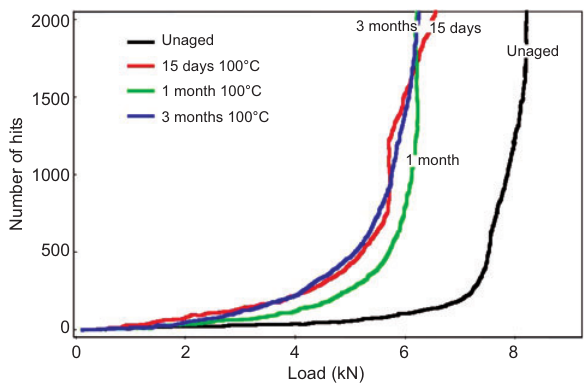
Figure 11 Decohesion at interface after 7 days ageing in deionised water at 100 ° C -300 bar. Observation by X-ray microtomography at ESRF (Grenoble, France) on ID19 beamline [13].